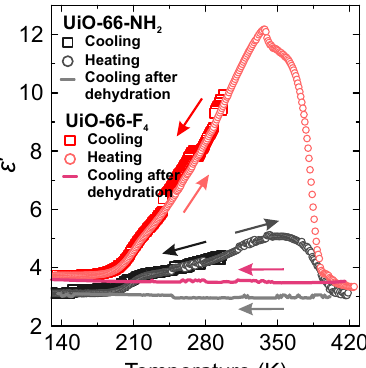
Figure 3. Real part of the complex dielectric permittivity of hydrated MOF samples measured at 1 MHz frequency during the cooling-heating-cooling cycle.